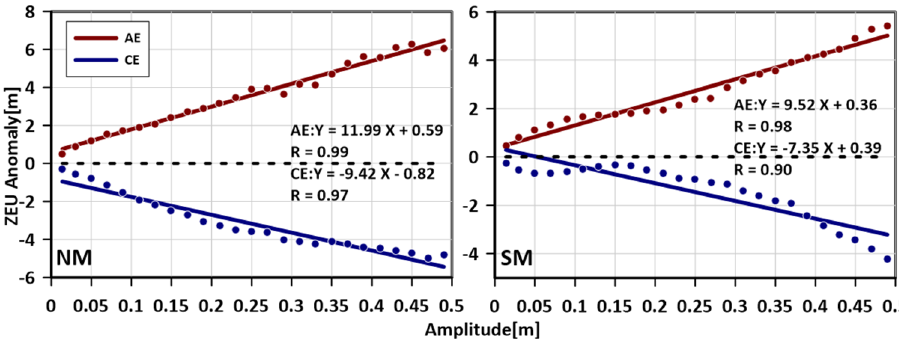
Figure 7. ZEU′ as a function of eddy amplitude. Mean amplitude and ZEU′ were calculated at 2 cm Figure 7. ZEU (cid:48) as a function of eddy amplitude. Mean amplitude and ZEU (cid:48) were calculated at 2 cm